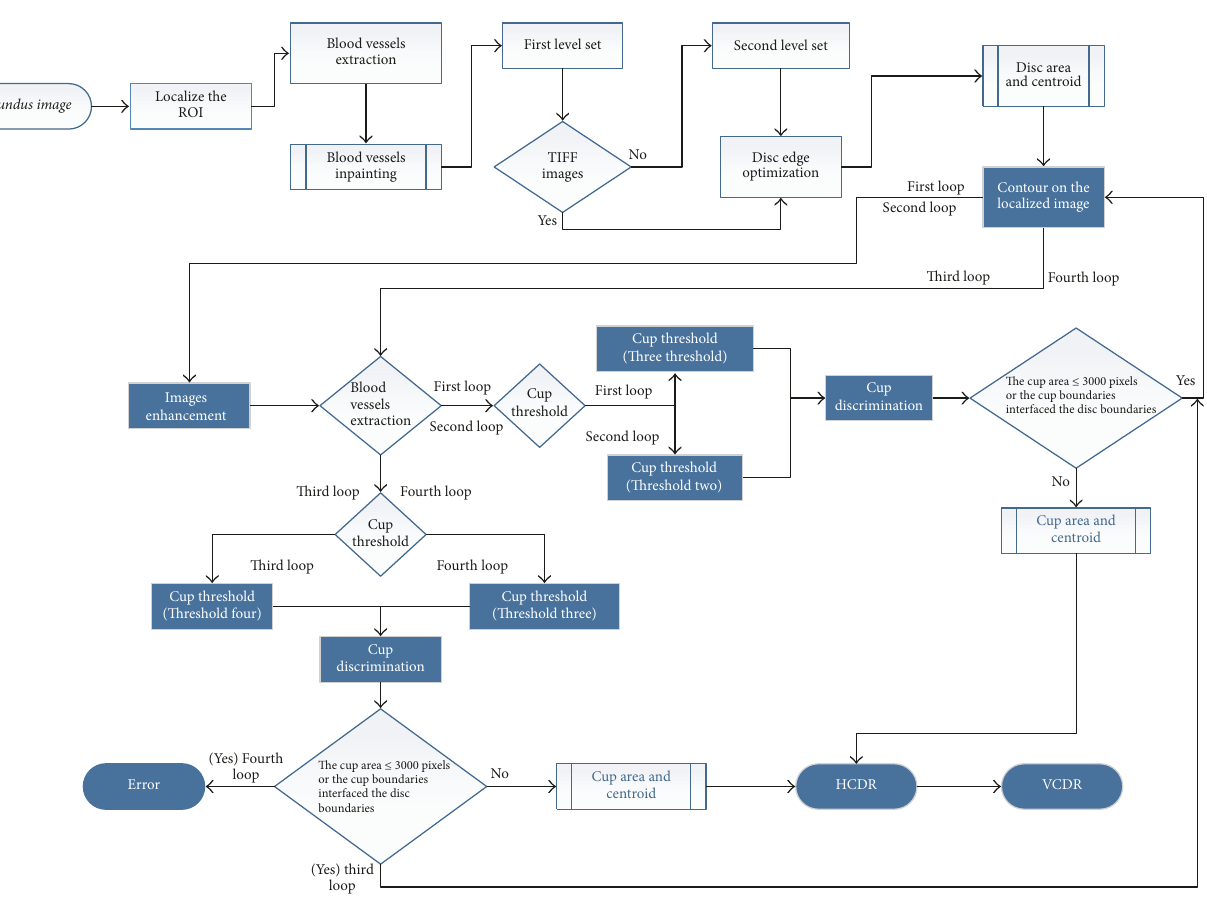
Figure 1: The final algorithm